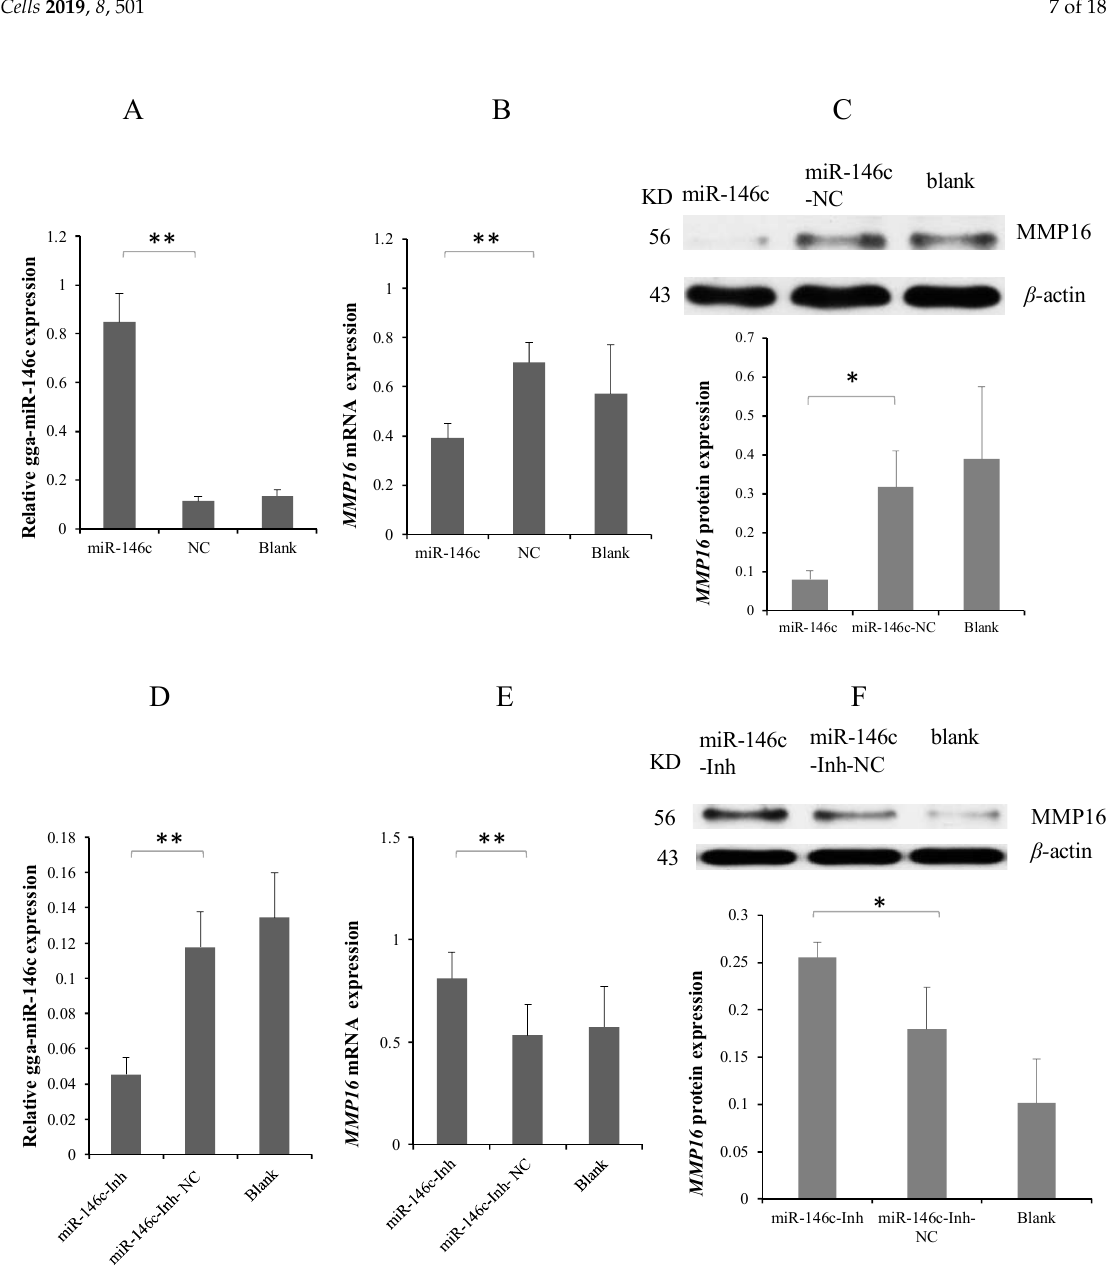
Figure 3. gga-miR-146c regulates MMP-16 expression. ( A ) The detection of gga-miR-146c overexpression; ( B and C ) DF-1 cells were transfected with gga-miR-146c mimics. MMP16 messenger RNA (mRNA) and protein expression was respectively measured by reverse transcription polymerase chain reaction (RT-qPCR) or Western blot, normalized to glyceraldehyde 3-phosphate dehydrogenase (GAPDH) or β -actin; ( D ) gga-miR-146c expression level was reduced with inhibitor transfection; ( E , F ) MMP16 mRNA and protein expression with gga-miR-146c inhibitor transfection was detected by RT-qPCR or Western blot respectively, normalized to GAPDH or β -actin; Values are mean ± SD, * p < 0.05, ** p < 0.01.